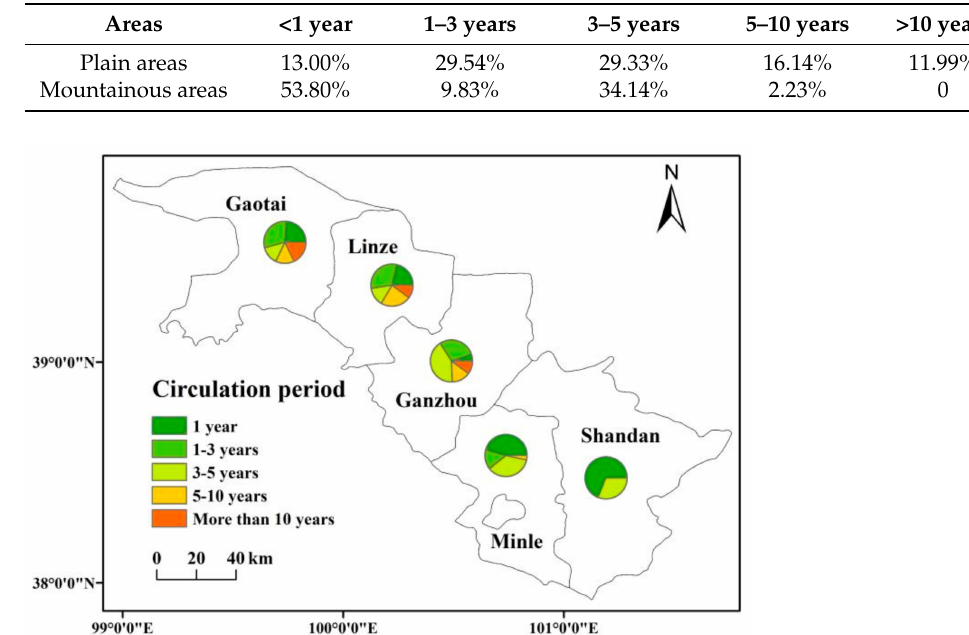
Table 6. Proportion of various farmland circulation period in plains and mountainous areas.